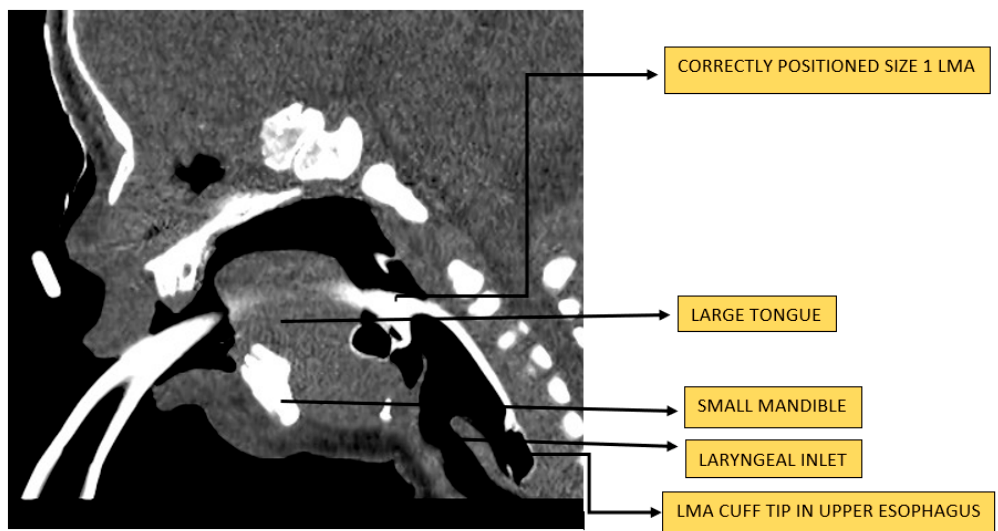
Figure 2. CT image of a size 1 LMA ® in situ in a neonate with severe micrognathia and congenital upper airway obstruction .